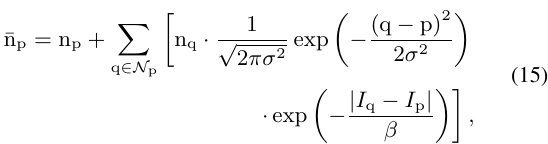
and second-lowest aggregated costs for each pixel in ¯ S